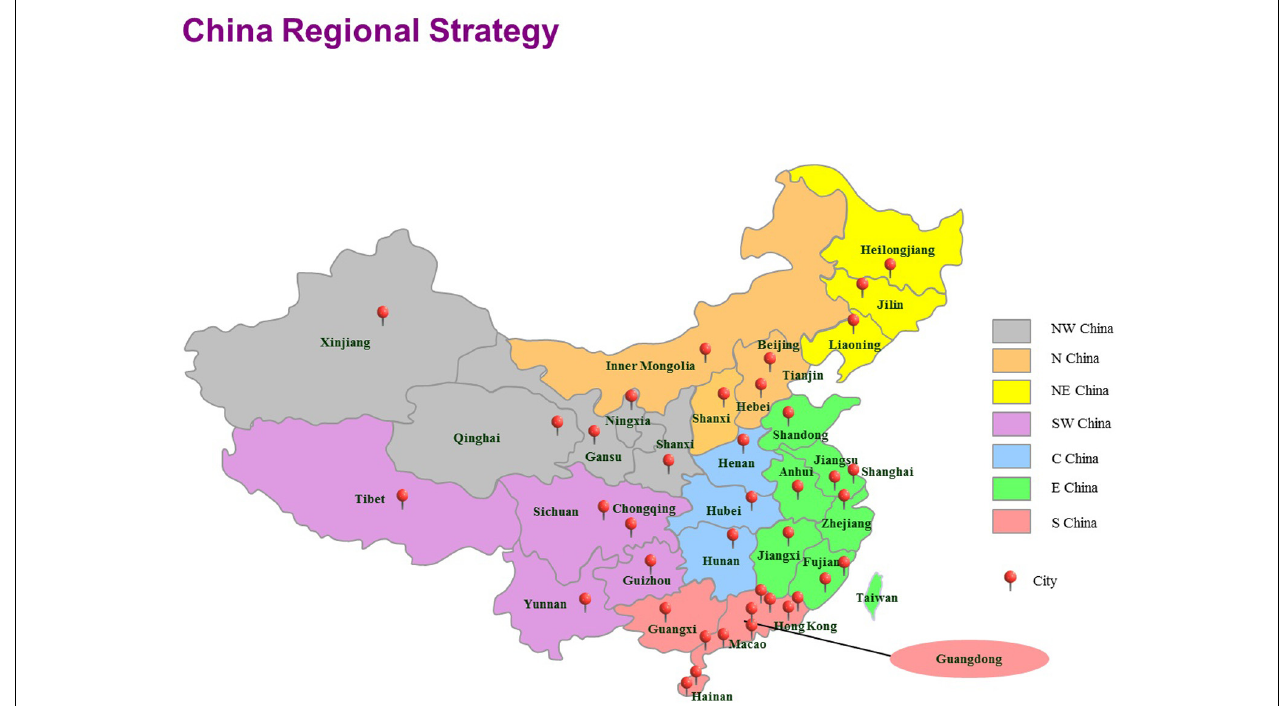
FIGURE 1 | The locations of the sampling sites for this study in China, including 39 cities. Seven geographical divisions based on the Chinese regional strategy are indicated using different colors. E, east; N, north; S, south; NE, northeast; NW, northwest. SW, southwest; C, central.